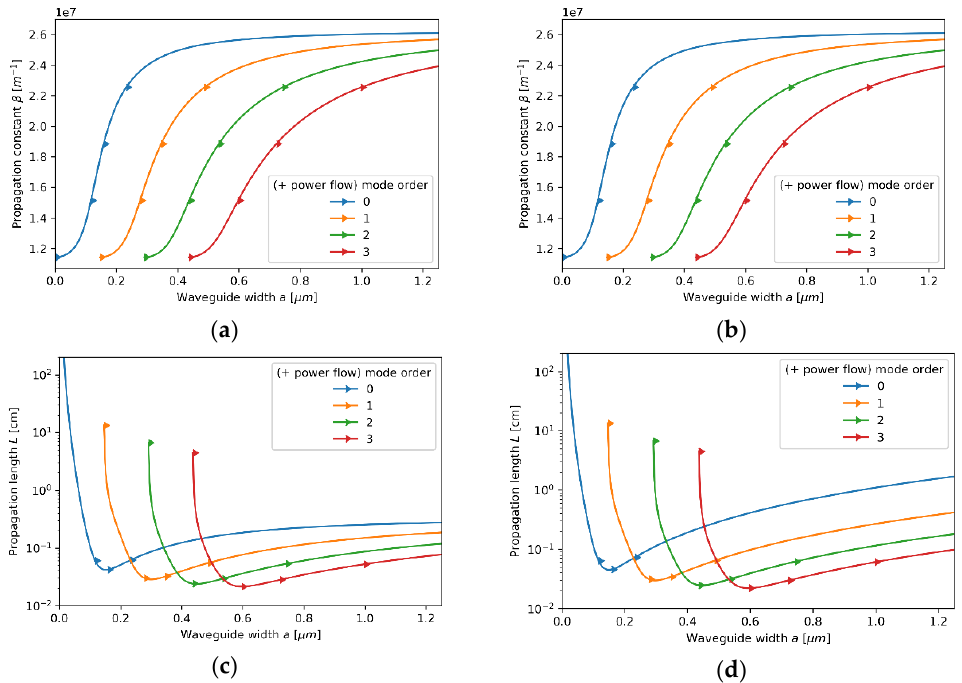
Figure 4. Propagation constant ( a , b ) and propagation length ( c , d ) of TM modes plotted versus waveguide width for an HMM waveguide with Nb2O5 layer of t Nb2O5 = 5 nm thickness embedded in the unit cell and described with local ( a , c ) and nonlocal EMT ( b , d ).